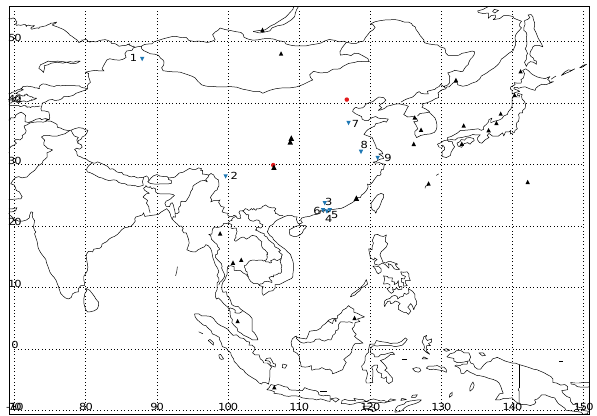
Fig. 3. The nested-grid model domain and locations of observa- tional data used in this study. The black triangles represent 25 sites from EANET; the red circles represent Miyun and Beibei sites with weekly observations; blue inverted triangles represent 9 Chi- nese rural sites from published papers: (1) Akdala, (2) Shangrl-La (X. Y. Zhang et al., 2012), (3) Conghua, (4) Tung Chung, (5) Tap Yun, (6) Zhongshan (Hagler et al., 2006), (7) Jinan (Yang, 2008), (8) Nanjing (Yang et al., 2005), and (9) Shanghai (Wang et al.,